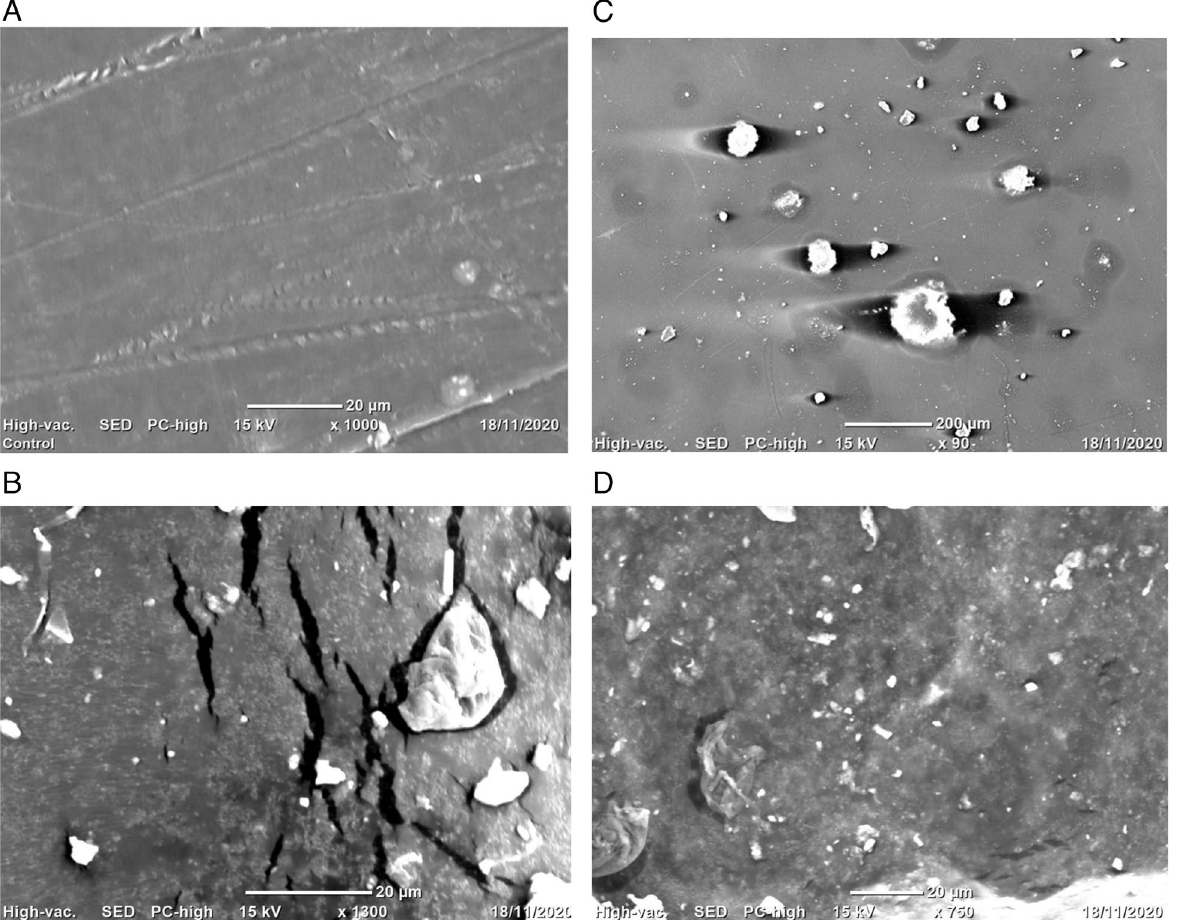
Fig. 3 Scanning electron micrograph of LDPE films after 60-day incubation with bacterial isolates showing surface disruption, holes, and wrinkles on the surface. A Control, B LDPE film after treatment with KS14, C LDPE film after treatment with KS119, and D LDPE film after treatment with